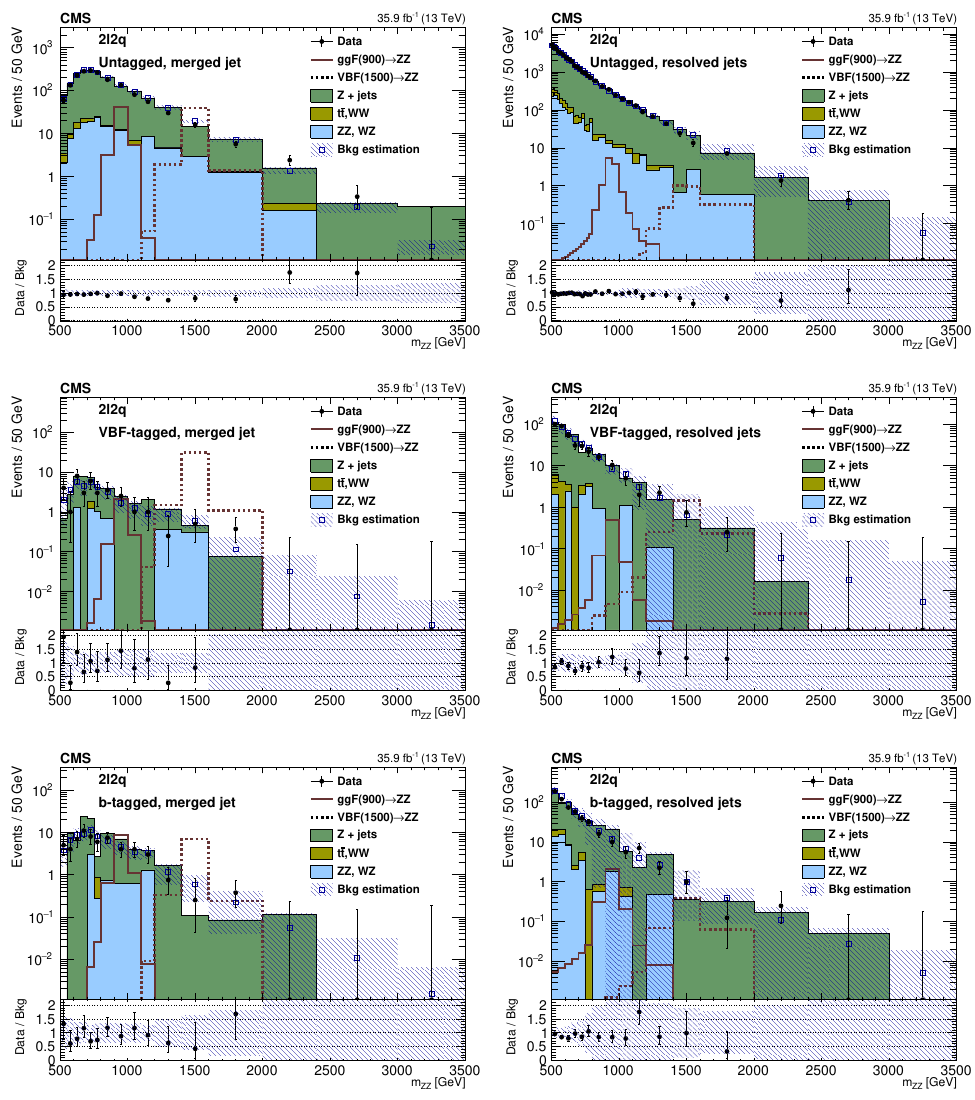
Figure 4 . Distributions of the invariant mass m ZZ in the signal region for the merged (left) and resolved (right) case for the di(cid:11)erent categories in the 2 ‘ 2q channel. The points represent the data, the stacked histograms the expected backgrounds from simulation, and the open histograms the expected signal. The blue hatched bands refer to the sum of background estimates derived from either simulation or control samples in data, as described in the text. Lower panels show the ratio between data and background estimation in each